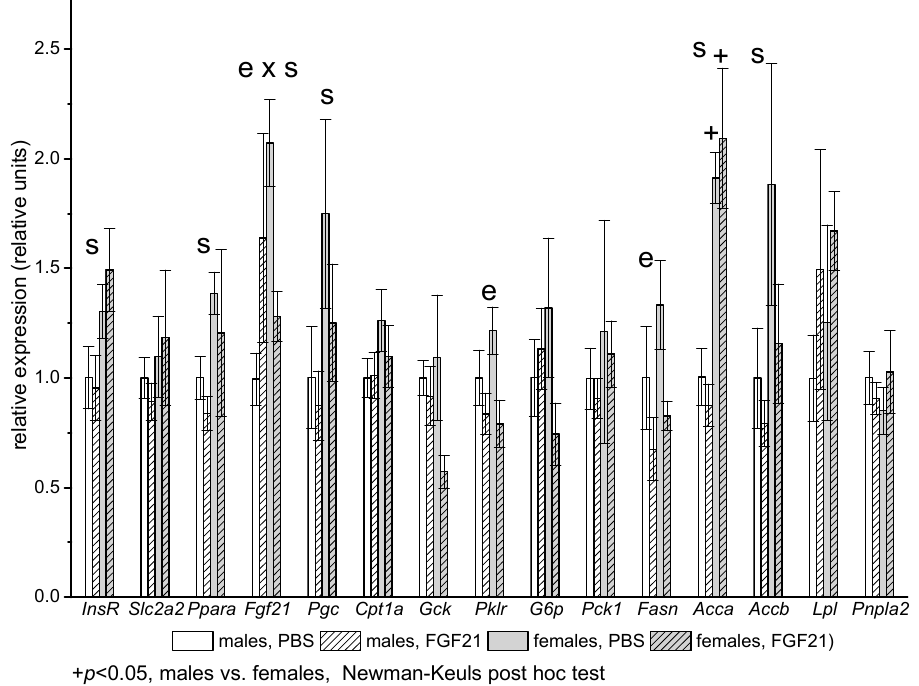
Figure 3. Influence of FGF21 administration on liver gene expression in male and female obese mice. Data are presented as mean ± SEM. Significant influence ( p < 0.05) of factors “e” (administration of PBS or FGF21), “s” (sex), and “e x s”, two-way ANOVA, are indicated in the plot.